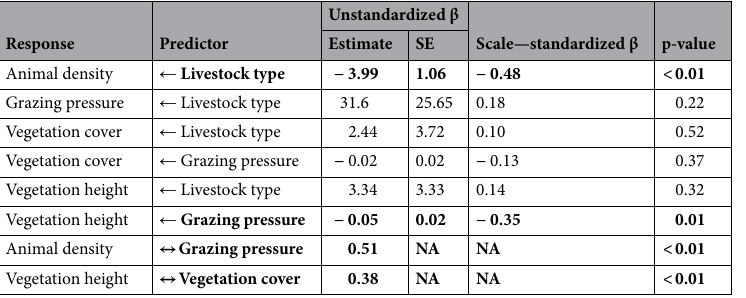
Table 2. Structural equation model (SEM) parameter estimates (β) and standard errors (SE) for management and vegetation variables (response variables paths and results shown in Supplementary Materials). Double- headed arrows indicate correlated errors and are shown in the column for unstandardized estimates. Significant effects are highlighted in bold.